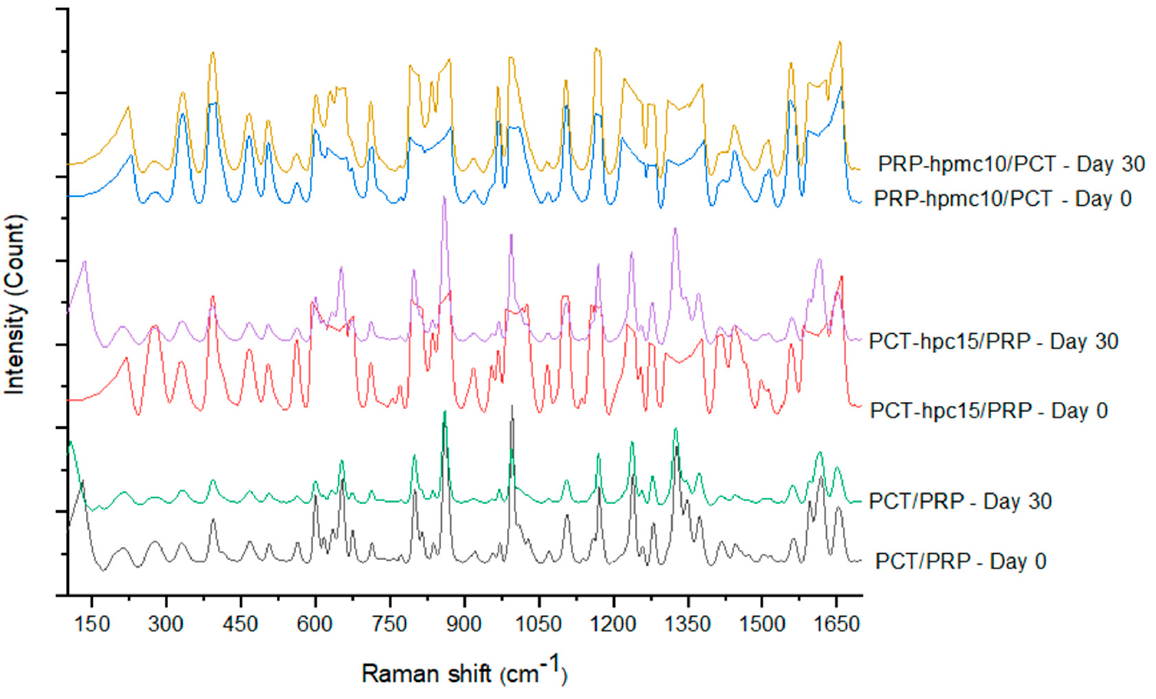
Figure 10. Raman spectra of experimental tablets at the beginning (Day 0) and at the end (Day 30) of the accelerated stability test.